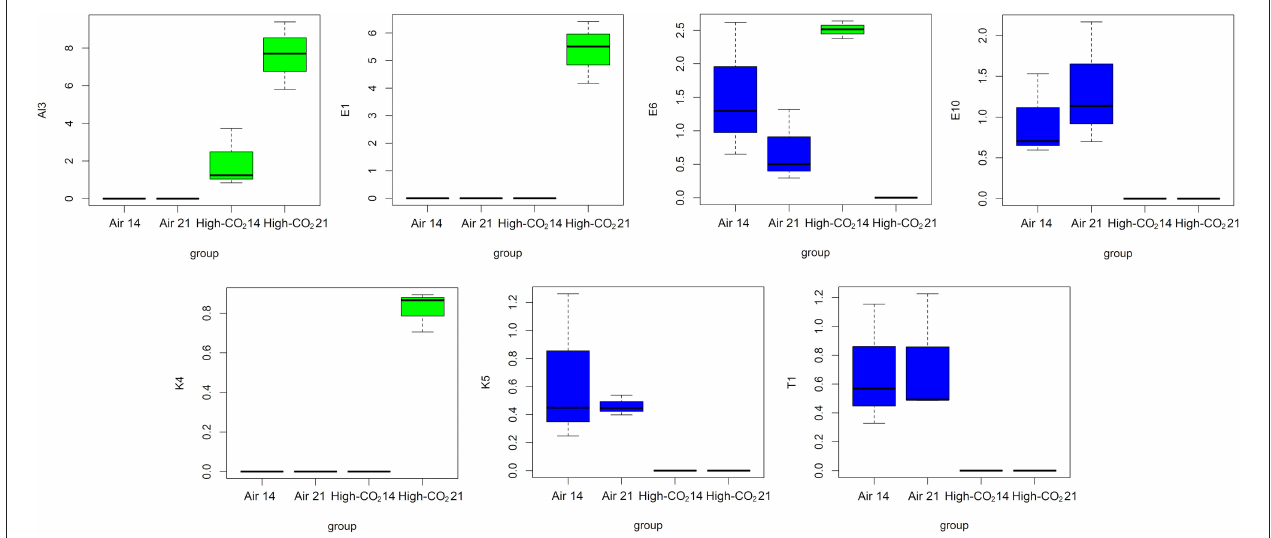
FIGURE 5 | Boxplots representing the distributions of the VOCs highlighted by ANOVA controlling the false discovery rate at the level δ = 0.05.